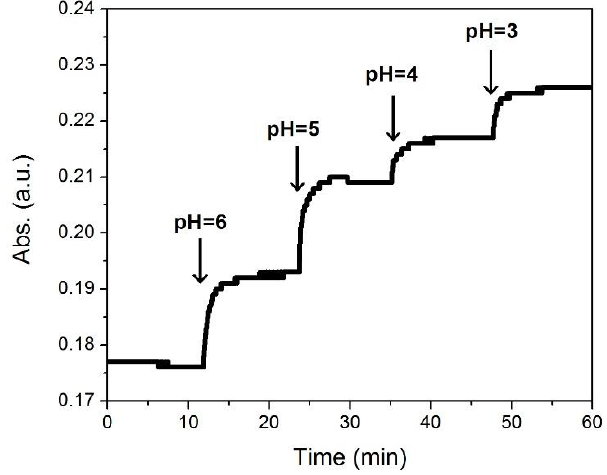
Figure 8. The real-time pH monitoring of a saliva sample (from a normal person) using a PANI-GNPs-glass biosensor at 785 nm. The time-point of HCl solution (pH = 1) titrations are indicated with arrows.